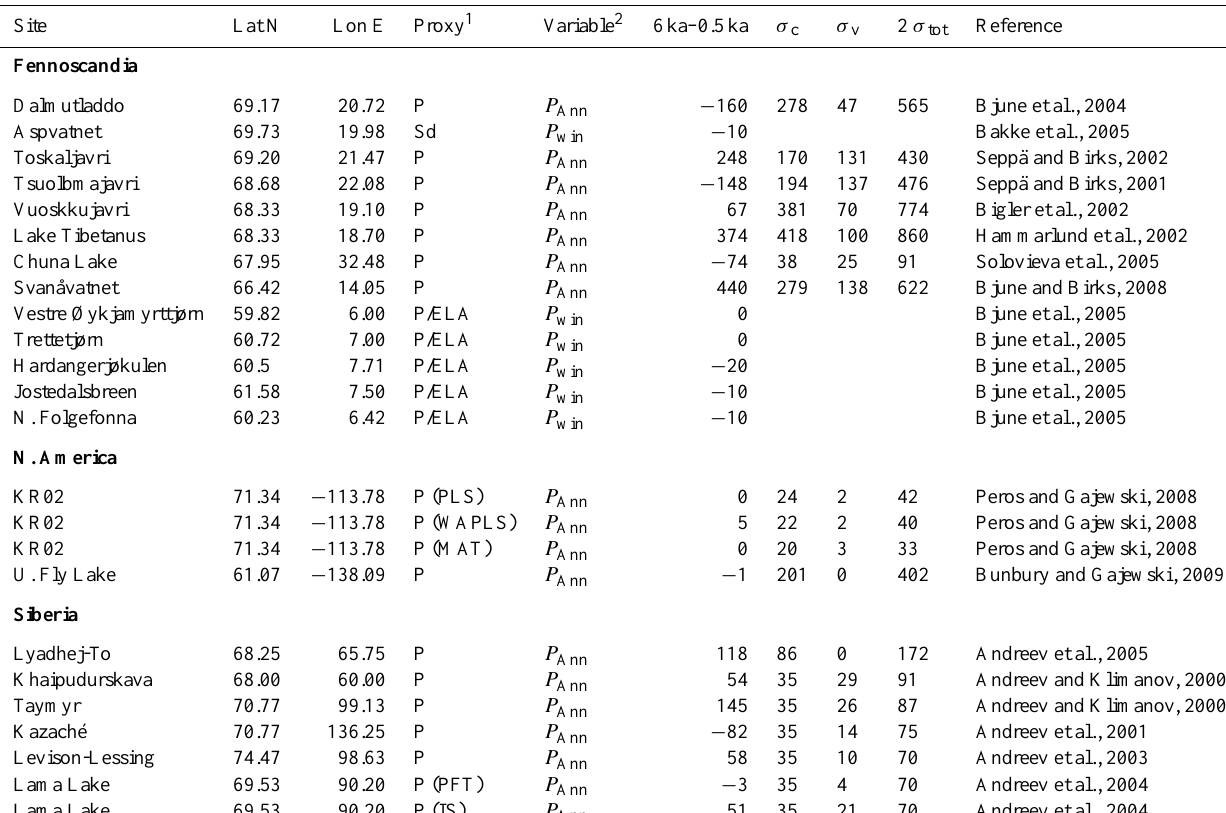
Table 1b. Precipitation reconstructions from proxy data discussed in this